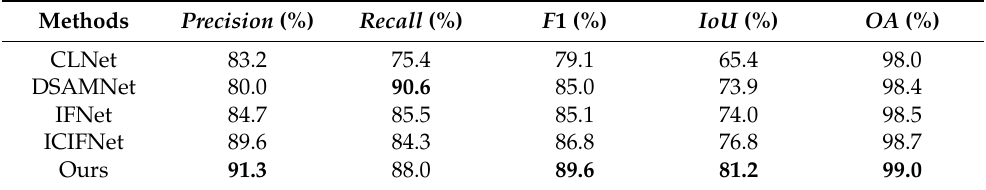
Table 2. Quantitative analysis of the LEVIRCD dataset. The highest metrics are in bold.